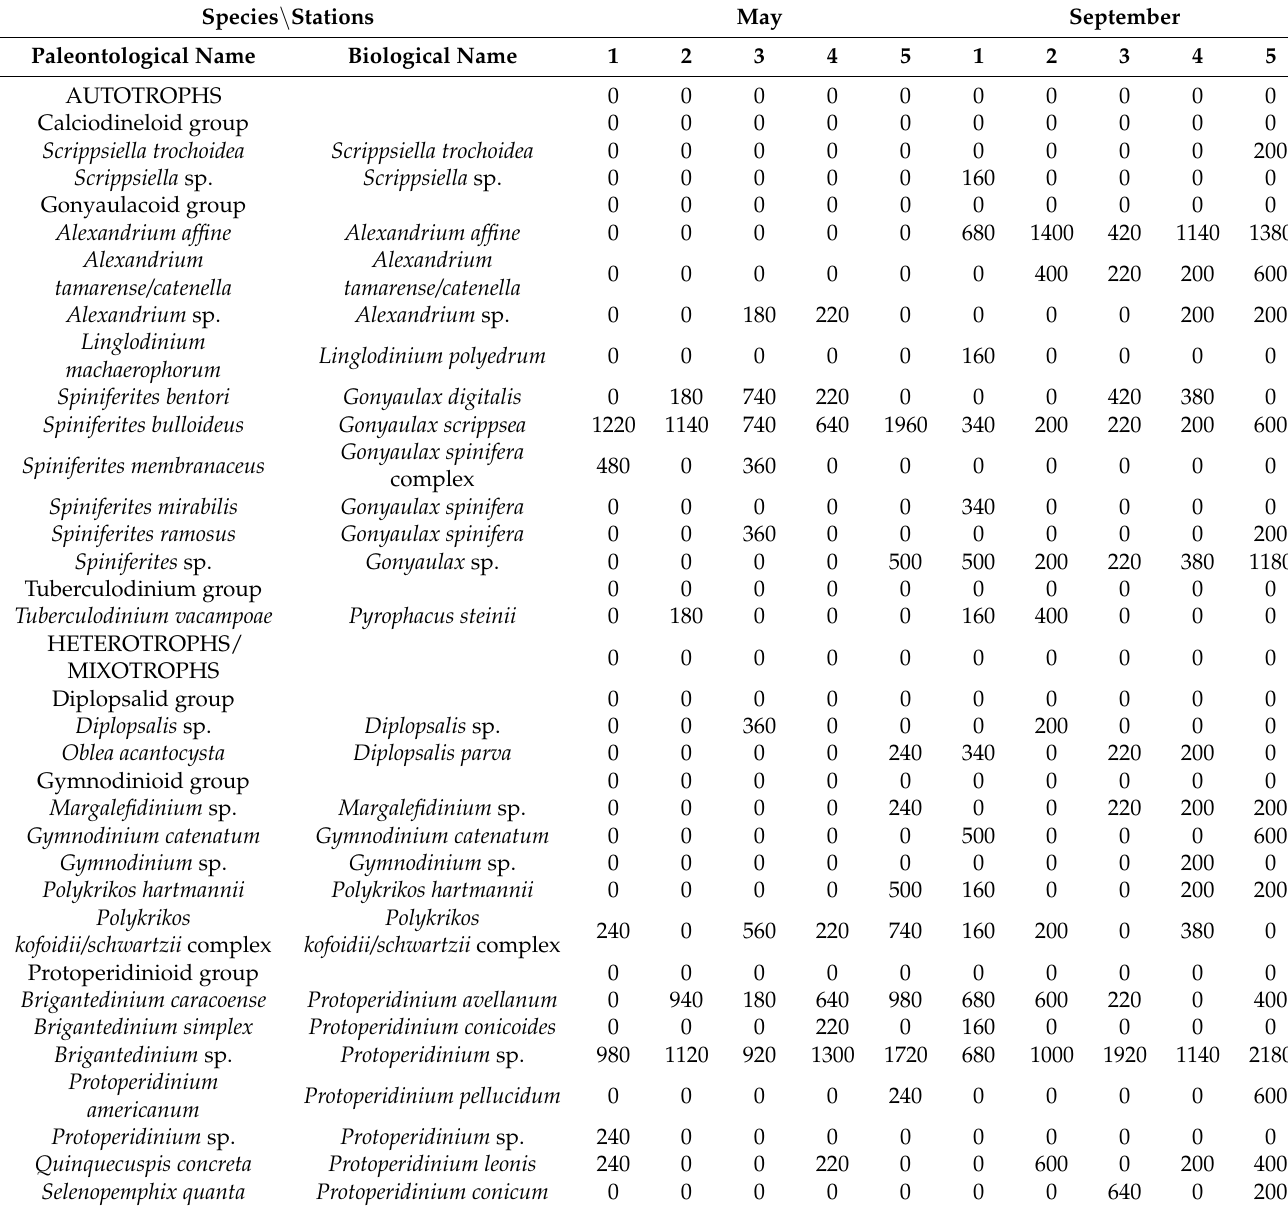
Table 3. Dinoflagellate cyst assemblages in the surface sediments in Tongyeong Sanyang-eup in May and September 2006 (cysts/g).